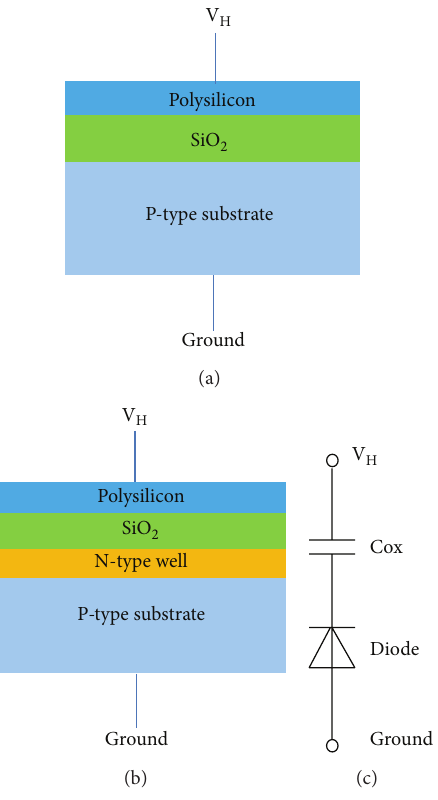
Figure 6: (color online) (a) Simplified vertical structure for resistor (b) added Nwell beneath the oxide to raise the breakdown voltage of the vertical